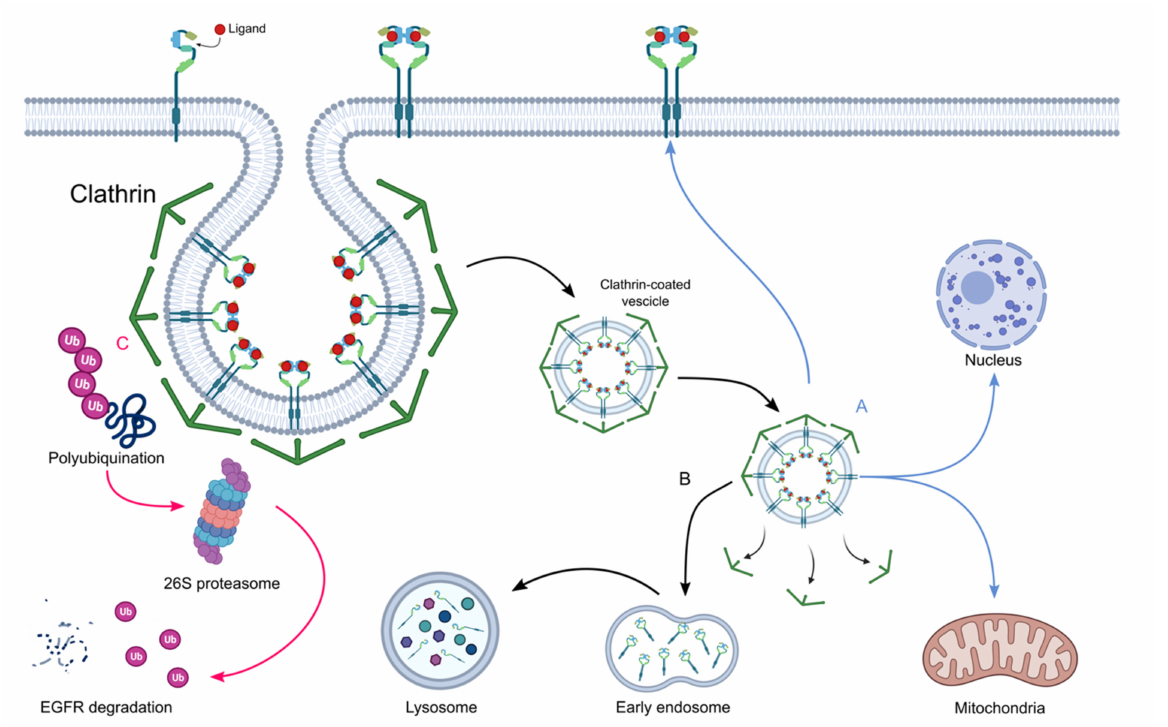
Figure 6. EGFR internalization, degradation, and reuse pathways. The active homodimer of EGFR is internalized through clathrin-coated vesicles, meaning ( A ) ligand-free receptors can be recycled in cell membrane. Alternatively, active EGFR may escape the degradation process and become tagged to the plasma membrane, nucleus, and mitochondria (blue arrows). ( B ) EGFR–ligand complexes are routed to lysosomes for degradation (black arrows) or ( C ) degraded via the proteosome pathway (pink arrows). Created with